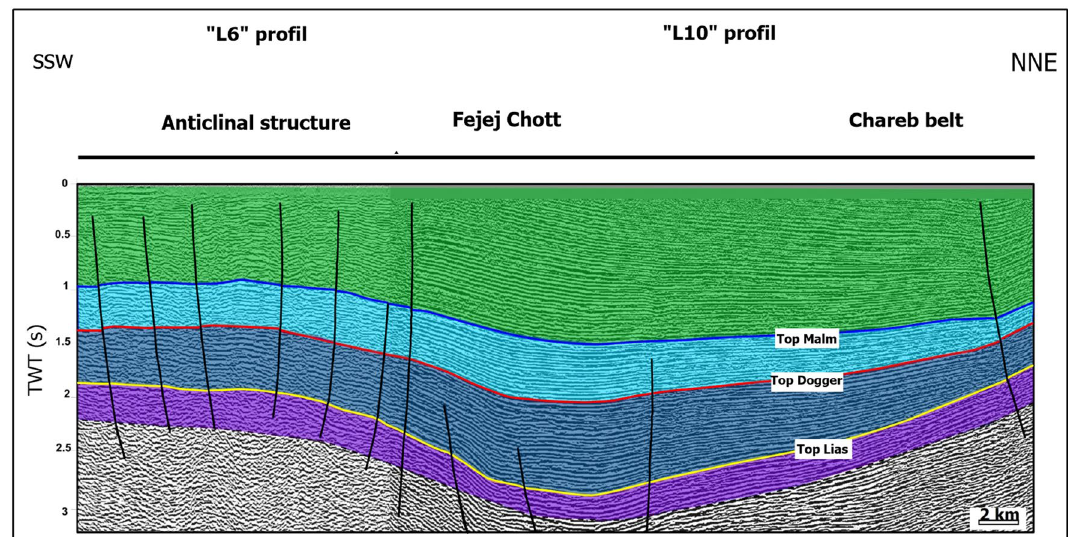
Fig. 10 The interpreted seismic profiles “L6” and